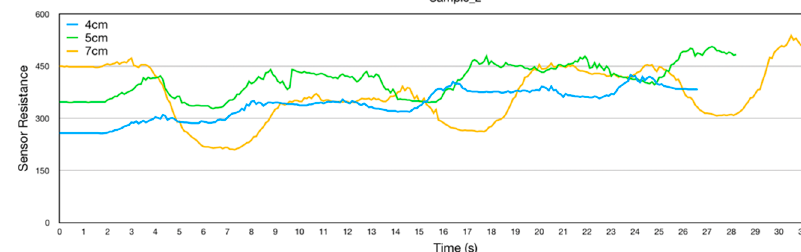
Figure 12. Results of sample 2.